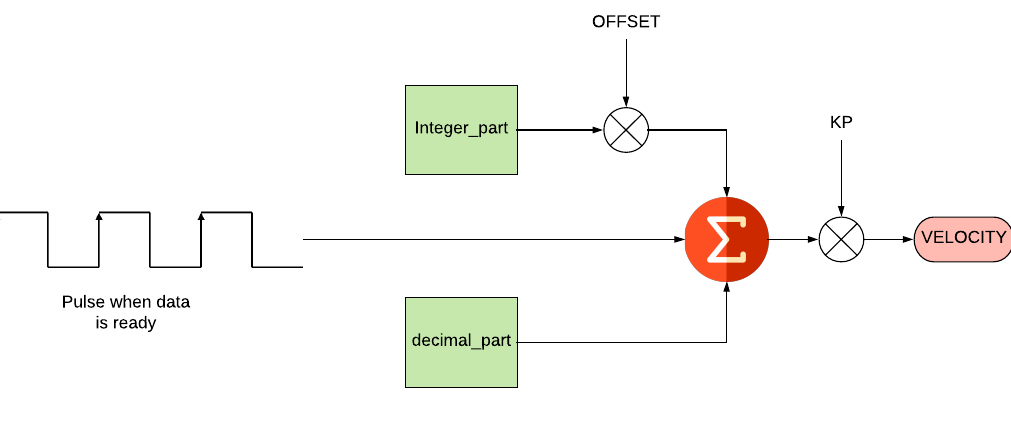
Figure 10. Flow diagram of P